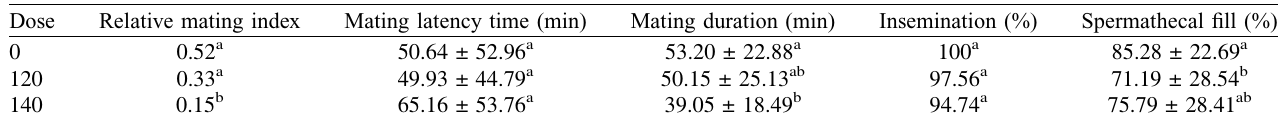
In a column, the values that have a common letter (a or b) are not signi fi cantly different ( p > 0.05).